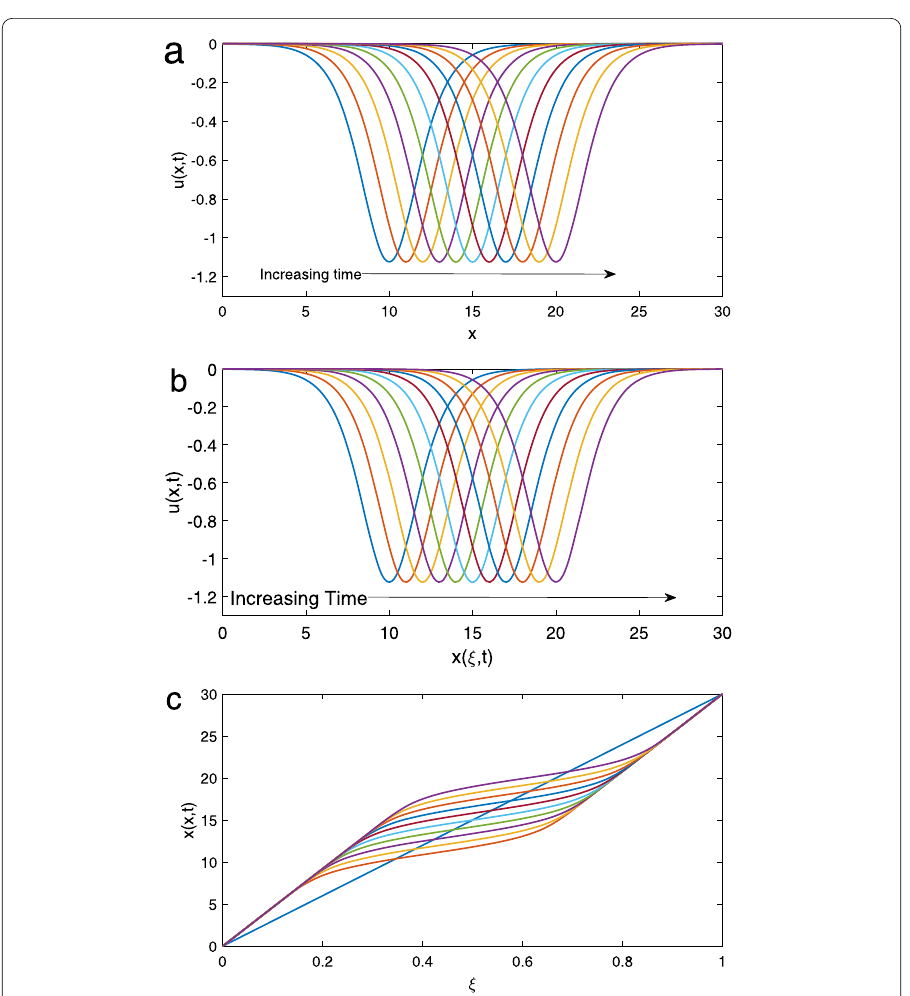
Figure 4 Diagrams ( a ) and ( b ) illustrate the time development of a single traveling wave for the exact and numerical solutions of u ( x , t ), respectively. In ( c ), we present the time evolution of the corresponding mesh x